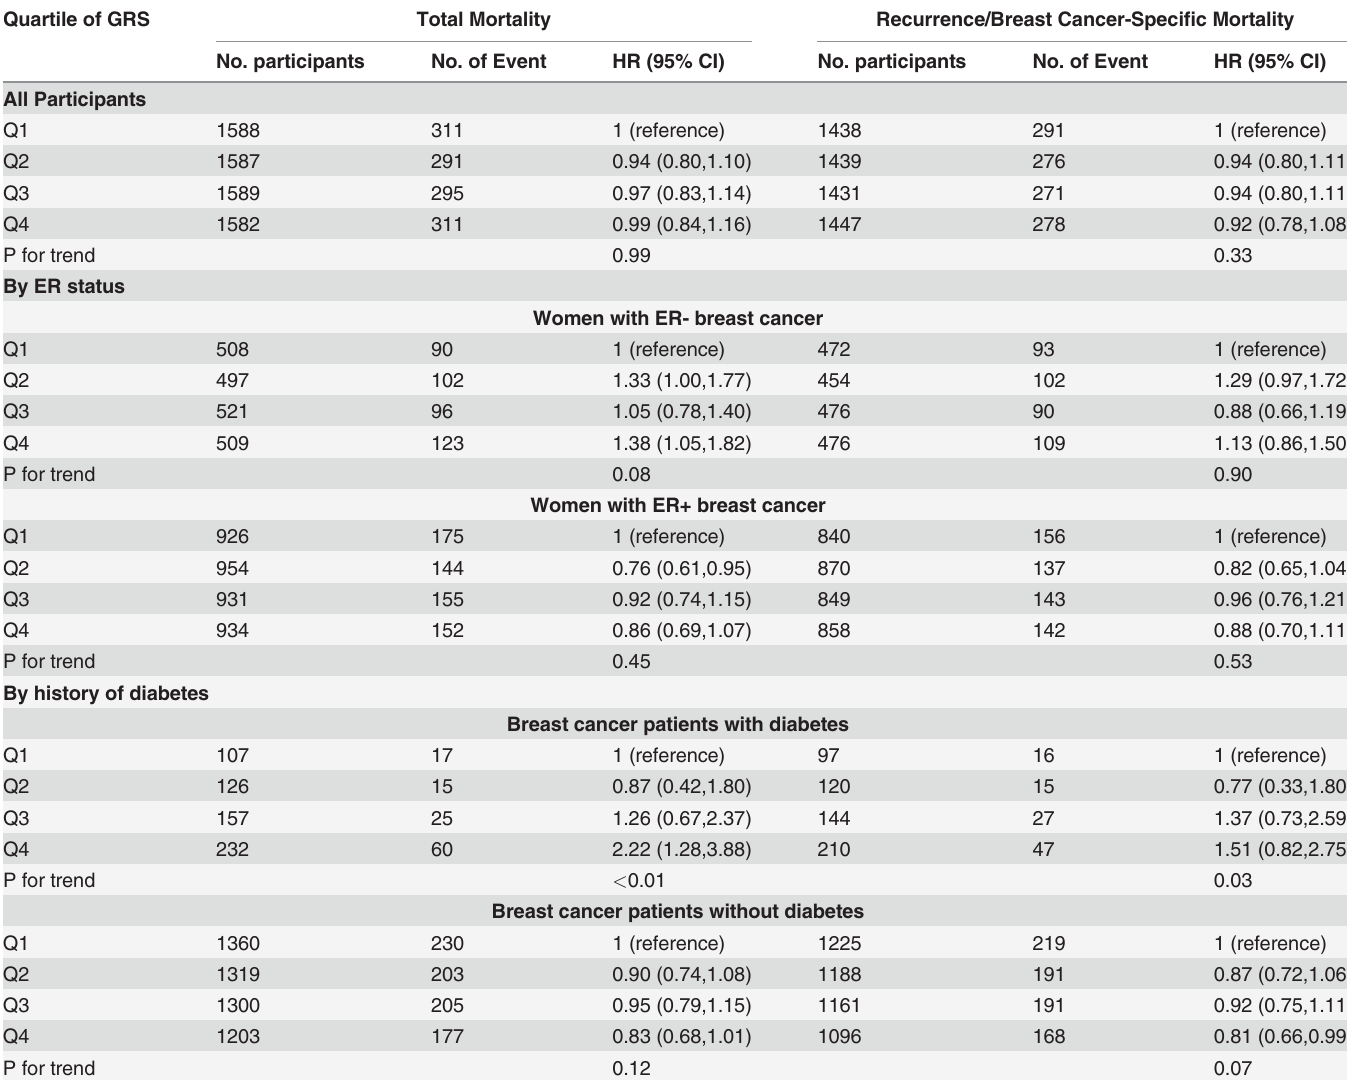
NOTE: All models adjusted for age at diagnosis (treated as continuous, using a restricted cubic spline with 5 knots) and TNM-stage. P values for interaction between ER status and weighted GRS were as follows: P = 0.28 for total mortality and P = 0.71 for recurrence or breast cancer-speci fi c mortality; P values for interaction between diabetes status and weighted GRS were as follows: P < 0.01 for total mortality and P < 0.01 for recurrence or breast cancer-speci fi c